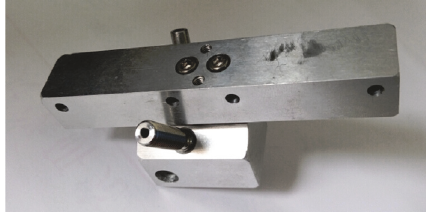
Figure 14: 3D printer device for color mixing.